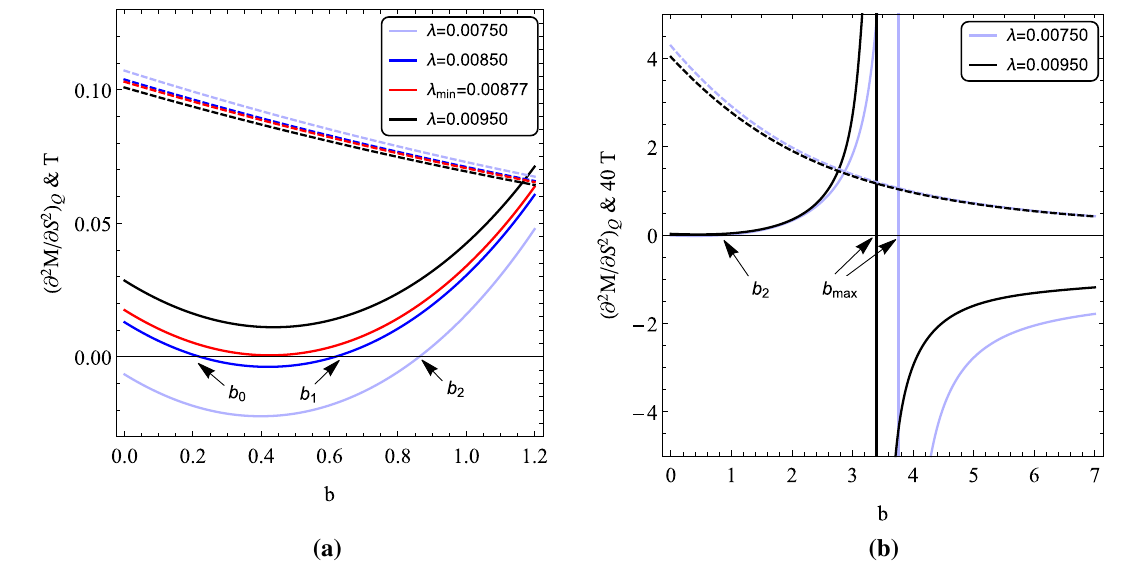
Fig. 2 The behaviors of (∂ 2 M /∂ S 2 ) Q and T (dashed) versus b for different values of λ with q = 1 and r h = 0 . 5